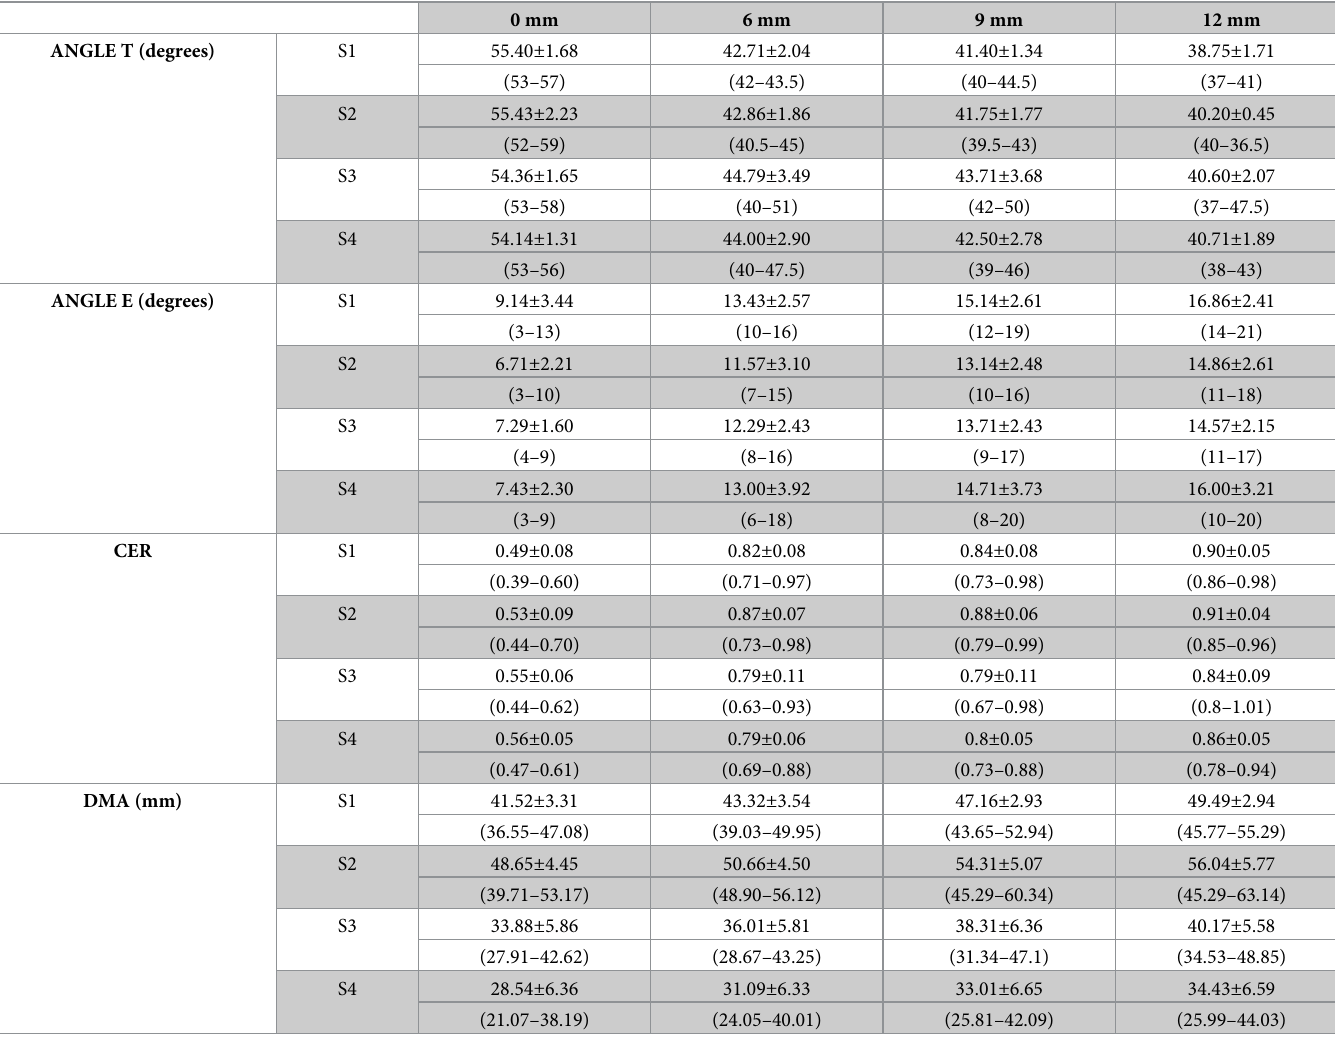
Table 4. Means, standard deviation, minimum and maximum values of the biomechanical parameters for different lateralization